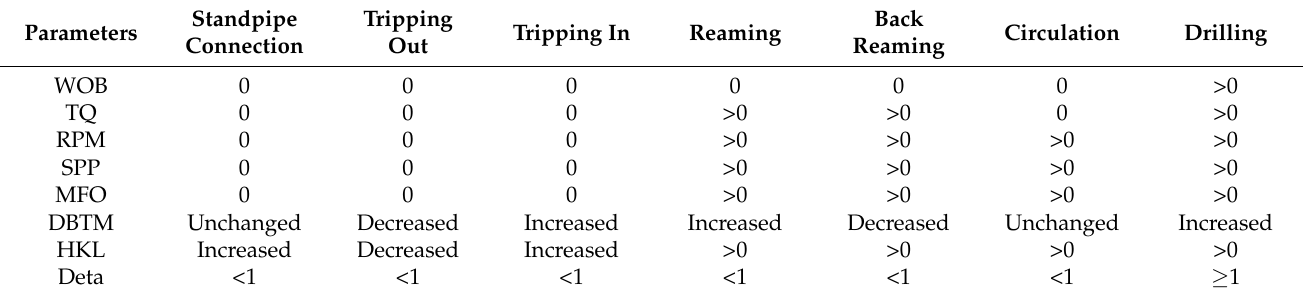
Table 1. Parameter changes in different drilling conditions.